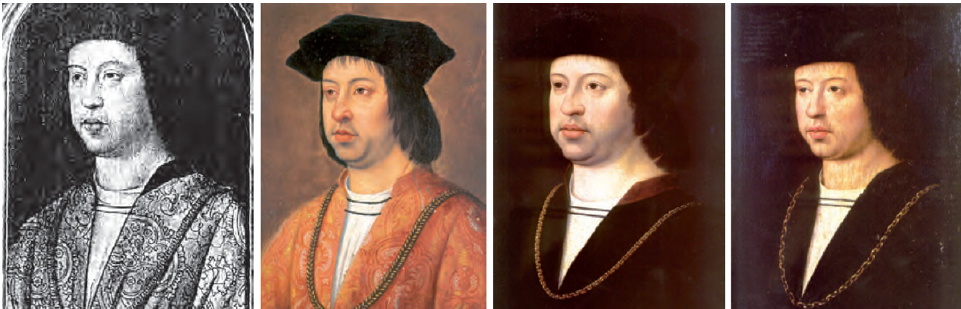
Figure 6. Fernando II portraits: Palacio Real, Windsor Castle. c. 1490–1500. Published by